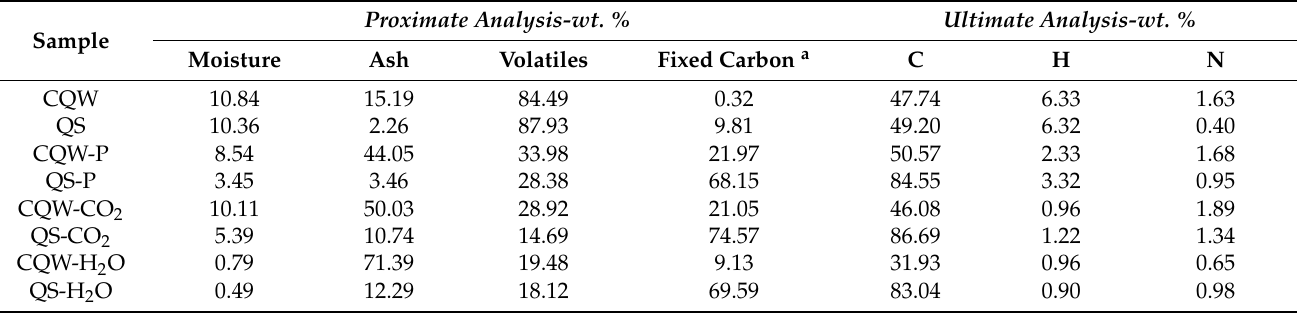
Table 2. Proximate and ultimate analysis of raw, pyrolyzed, and activated carbons. Proximate Analysis-wt.